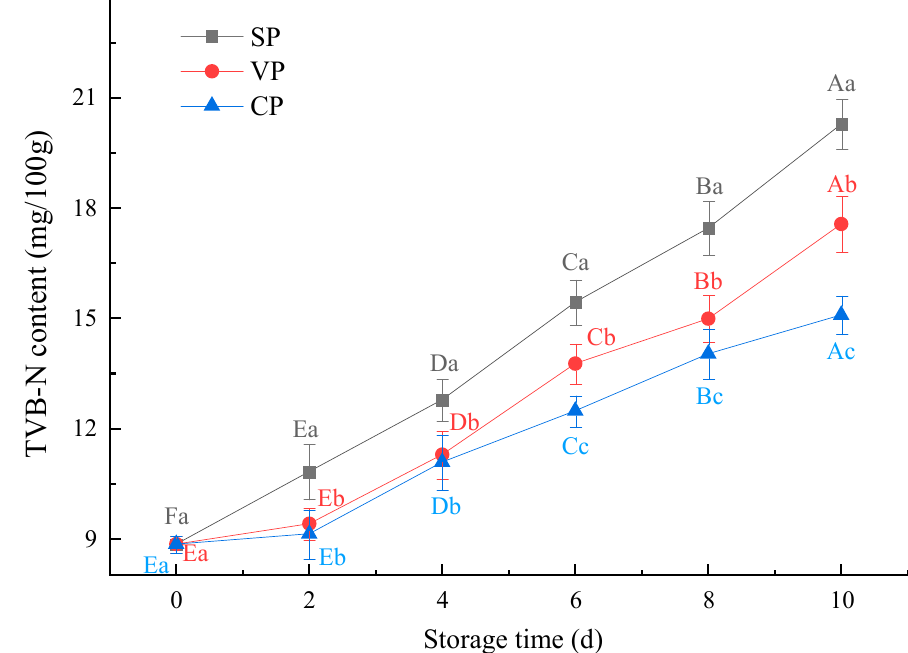
Figure 2. Changes in the TVB-N content of pike eels over 10 days of chilled storage. SP, simple packaging; VP, vacuum packing; and CP, stable chlorine dioxide pretreatment combined with vacuum packing. Different uppercase letters indicate significant differences in the TVB-N content of pike eels during 10 days of chilled storage ( p < 0.05). Different lowercase letters indicate significant differences in the TVB-N content of pike eels for the same storage time ( p < 0.05).